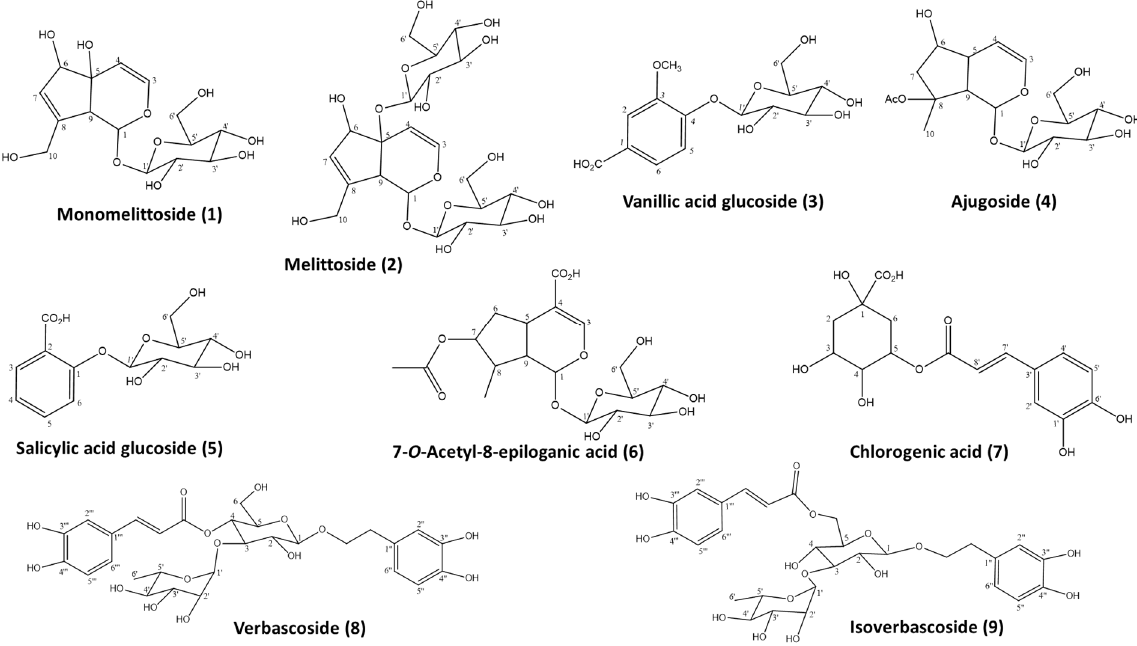
Figure 1. Structures of isolated iridoid, phenylpropanoid, and phenolic acid glycosides. Monomelittoside ( 1 ) with the molecular structure C 15 H 22 O 10 and a molecular weight